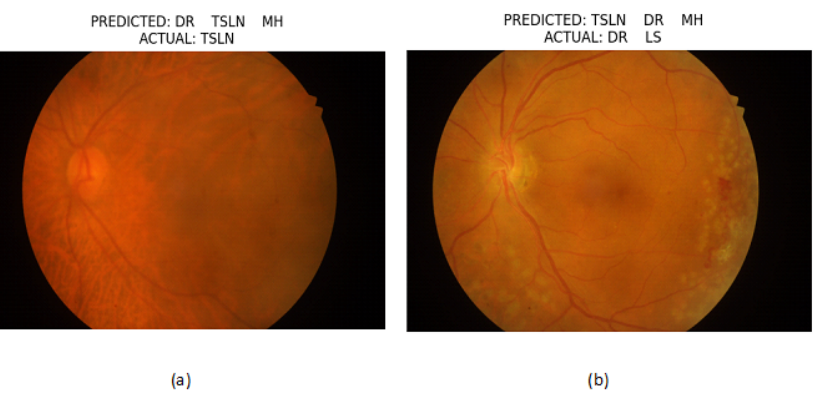
Figure 9. The precision and recall curve of the proposed ML-CNN model.